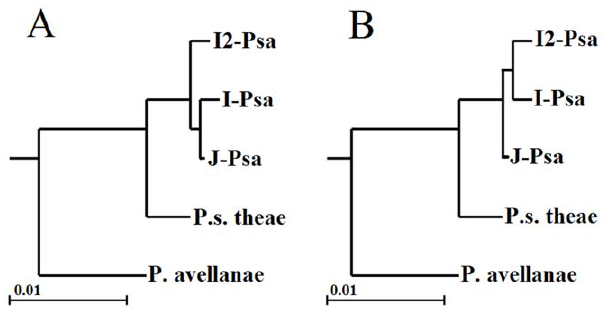
Figure 5. Genealogy of strains of genomospecies 8. (A) Maximum likelihood tree resulting from the analysis of a concatenation of 171 ORFs. (B) An alternative genealogical hypothesis with the constrain of the common origin of the Italian Psa strains.